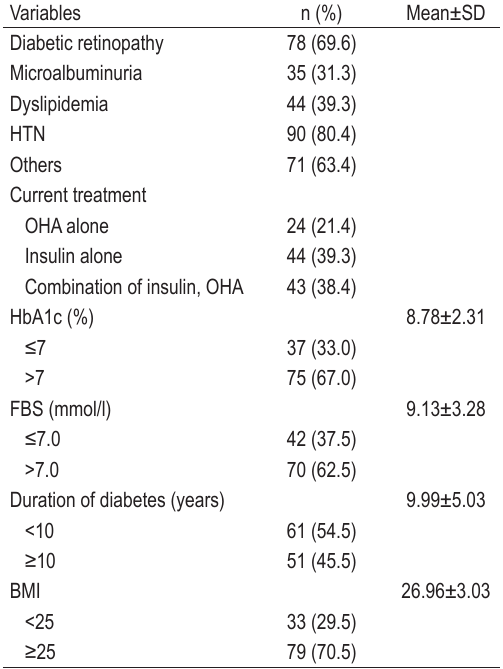
TABLE 2. Distribution of disease-related characteristics among the participants